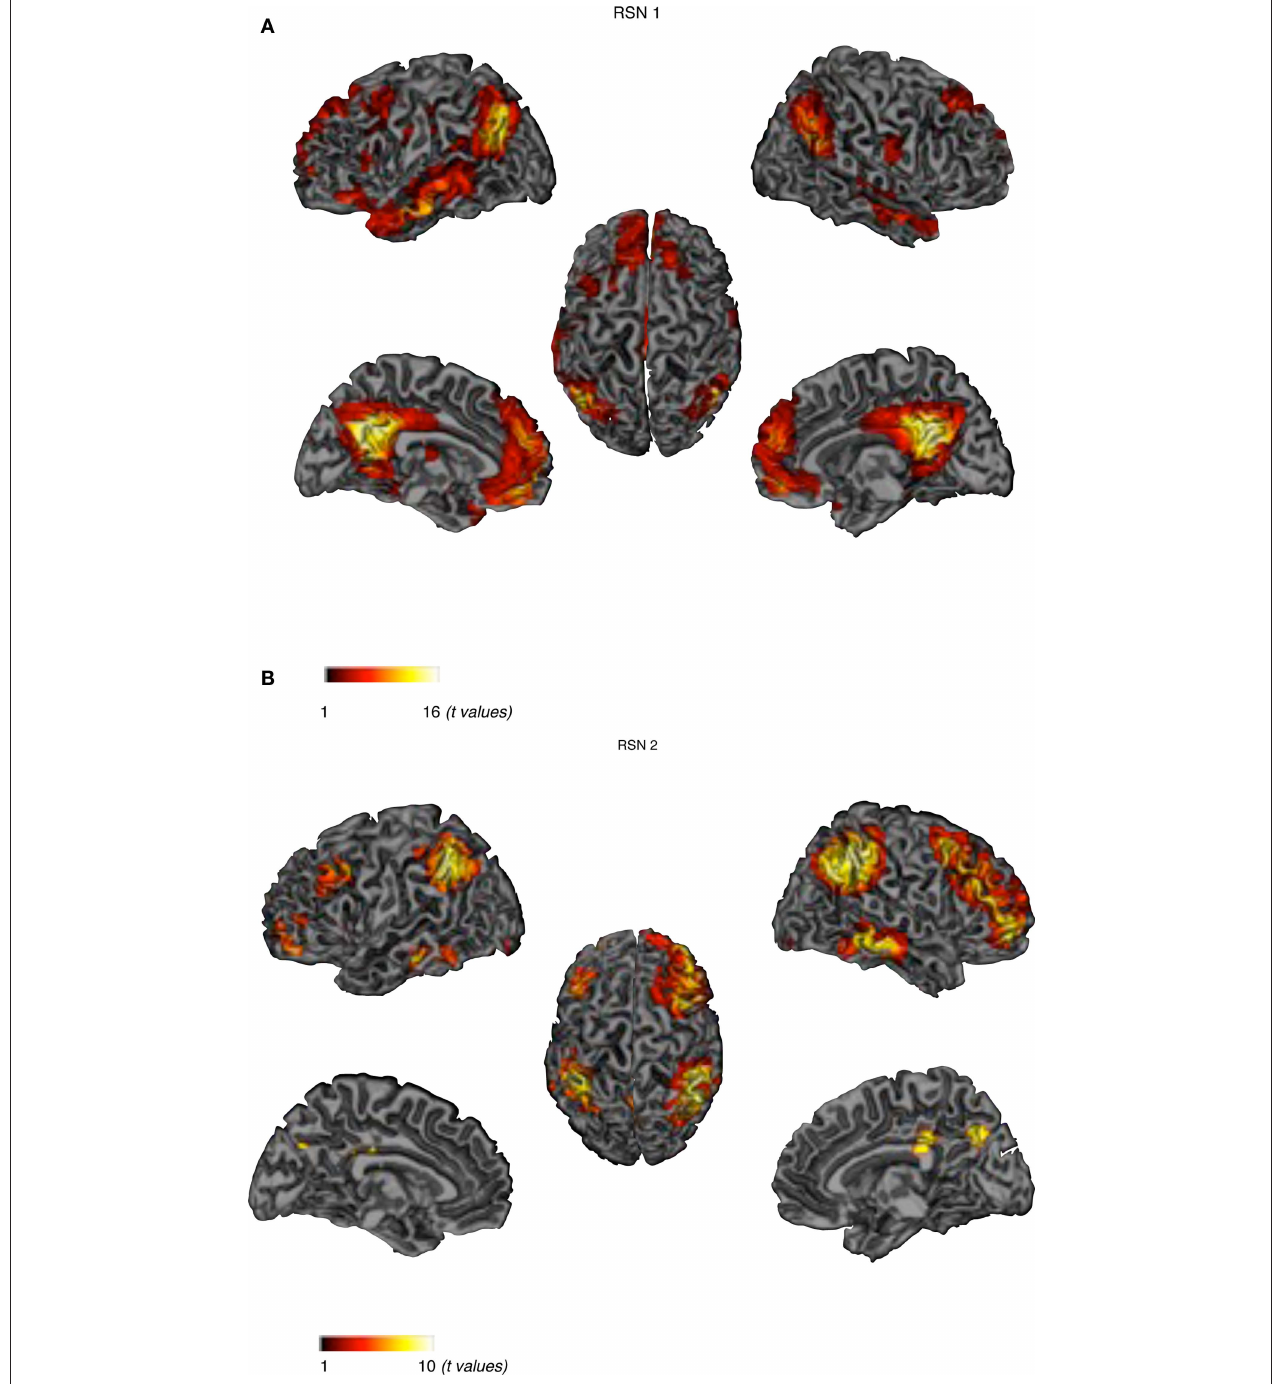
FIguRe 1 | Cortical representation of the activity in the six RSNs. For each RSN (Left) Lateral and medial views of left hemisphere. (Center) Dorsal view. (Right) Lateral and medial views of right hemisphere. (A) Default-mode network – DMN, (B) dorso-lateral attention network – DAN.